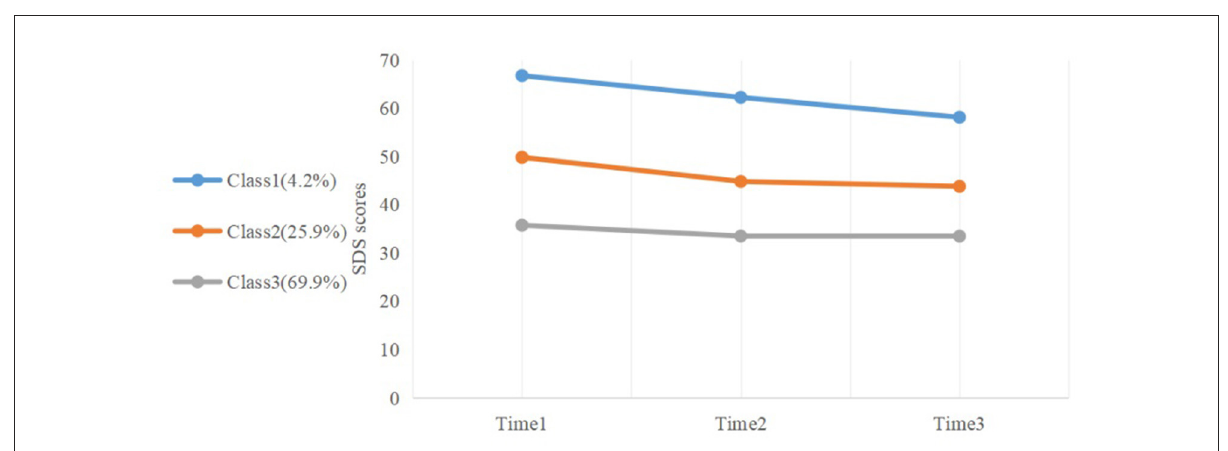
FIGURE2 Plot of depressive symptom trajectories during college, derived from latent class growth analysis (LCGA).